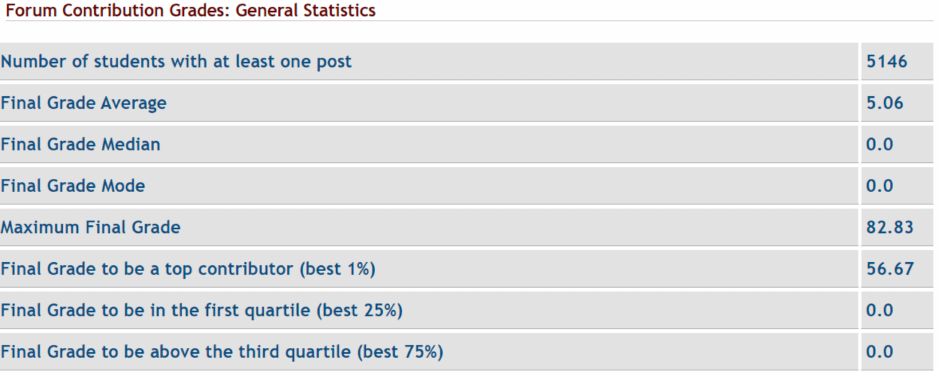
Figure 8. Example summary table of learners’ grades on a range from 0 to 100. It is important to note that with the input values used, most learners got 0 points. This is because many of them only sent one single, not very relevant, message (presentation